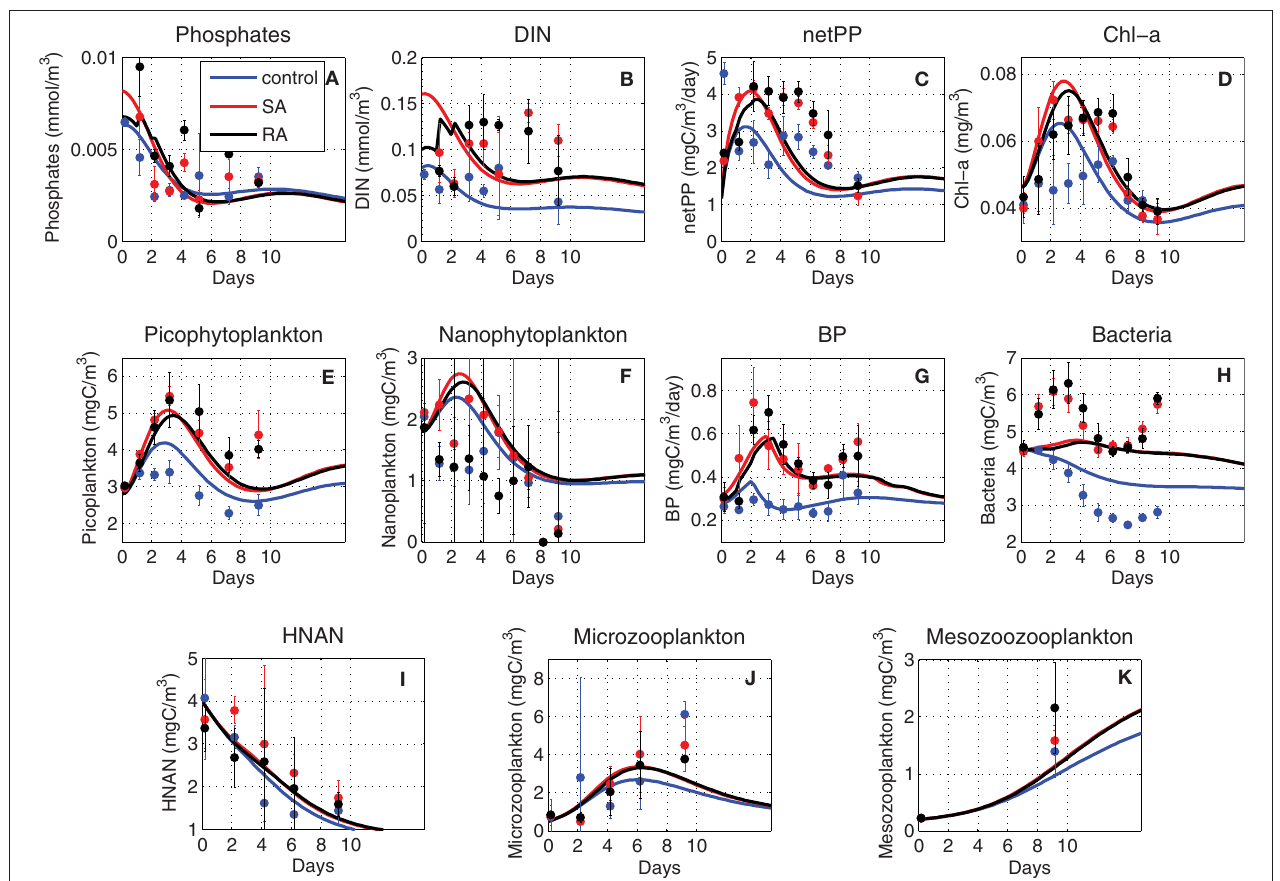
FIGURE 2 | Model simulated (A) phosphate (mmol/m 3 ), (B) dissolved inorganic nitrogen (DIN, mmol/m 3 ), (C) net primary production (netPP, mgC/m 3 /day), (D) Chl-a (mg/m 3 ), (E) picophytoplankton biomass (mgC/m 3 ), (F) nanophytoplankton biomass (mgC/m 3 ), (G) bacterial production (BP, mgC/m 3 /day), (H) bacteria biomass (mgC/m 3 ), and (I) HNAN biomass (mgC/m 3 ), (J) microzooplankton biomass (mgC/m 3 ), (K) mesozooplankton biomass (mgC/m 3 ), for the three (Control blue line, Single Addition/SA red line and Repetitive Addition/RA black line) treatments, against observations. The standard deviation of measurements from three = = replicates is